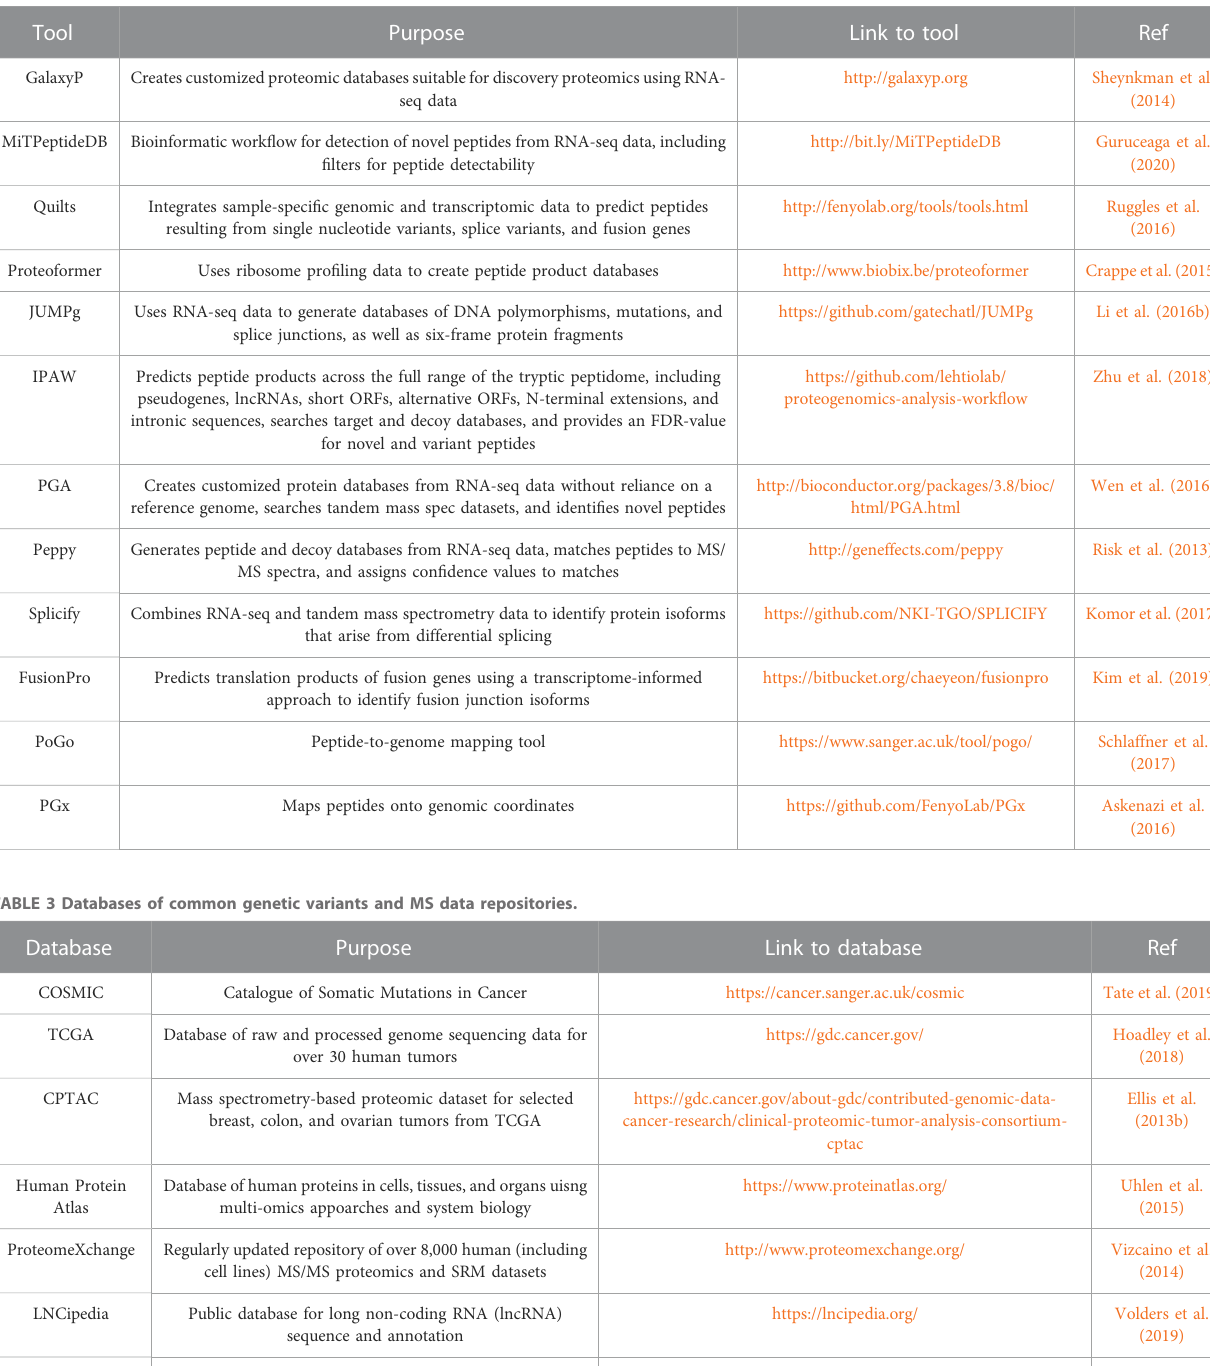
TABLE 2 Informatic tools for creating customized protein sequence libraries using RNA-seq data. Tool